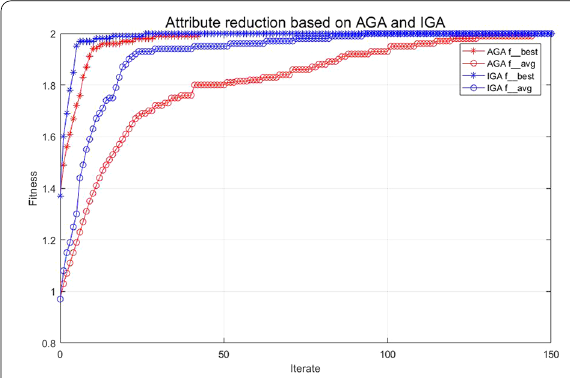
Figure 7 Attribute reduction based on the adaptive genetic algorithm and improved genetic